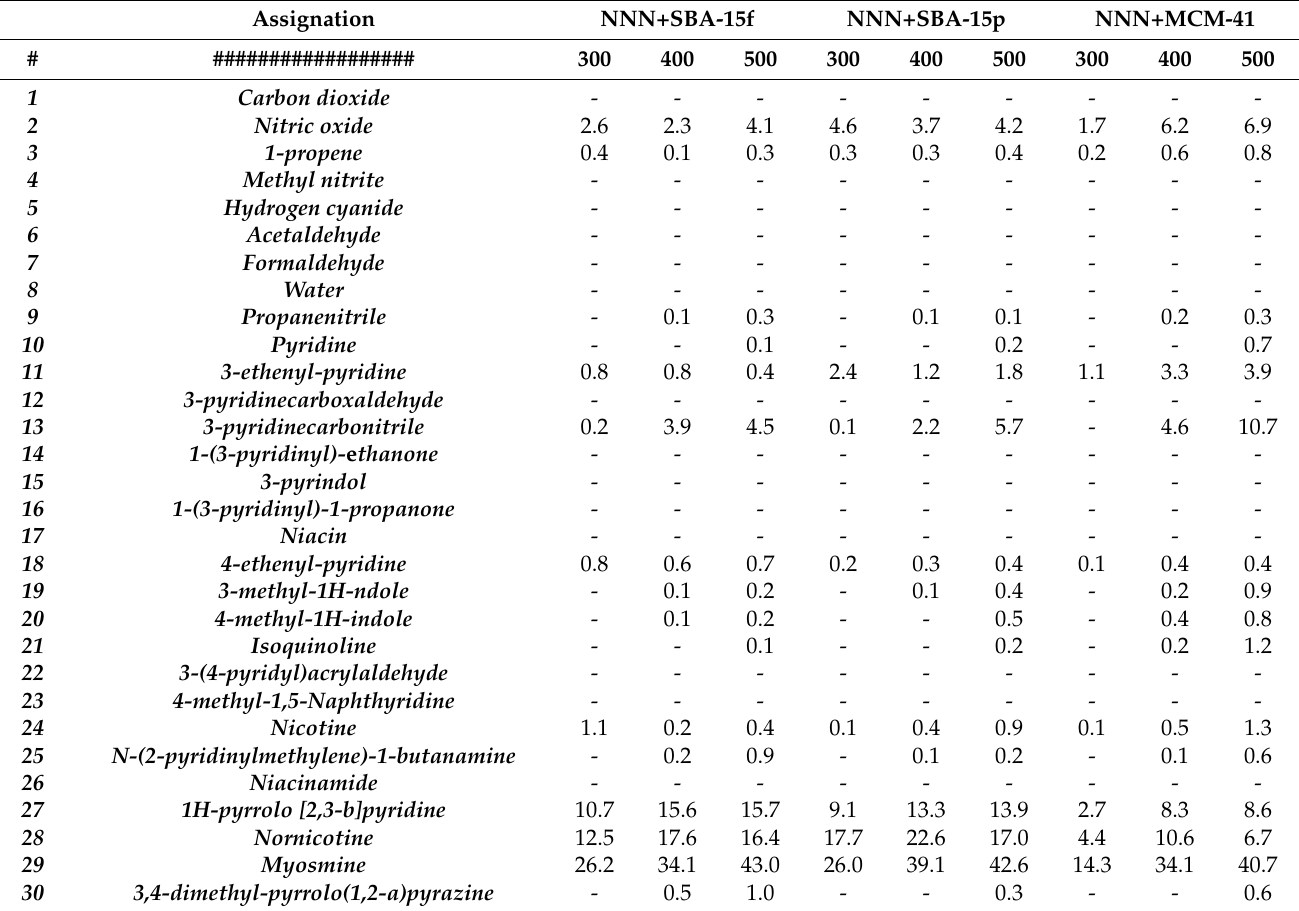
Table A2. Contribution of total area (%) of assigned compounds in the catalytic pyrolysis of NNN with three catalyst under the inert atmosphere at different temperatures ( ◦